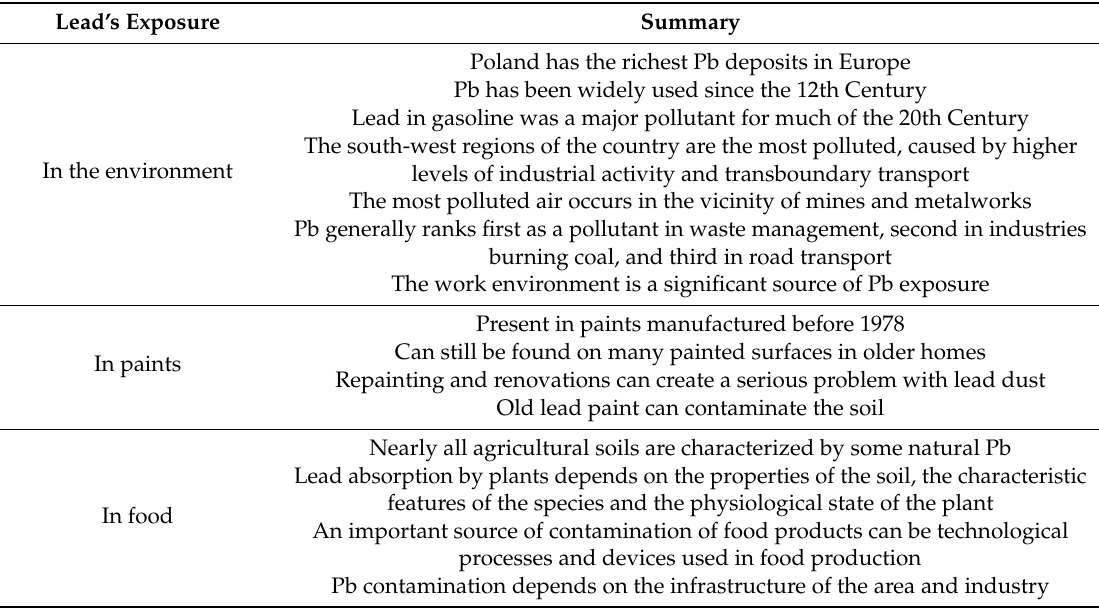
Table 4. Lead exposure in Poland—a